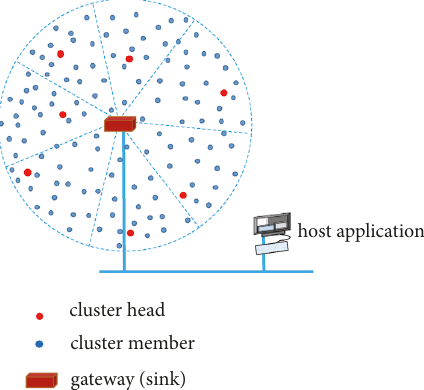
Figure 2: The WirelessHART network is modelled as a hierarchical cluster network, where the red nodes represent the cluster heads and the blue nodes represent the cluster